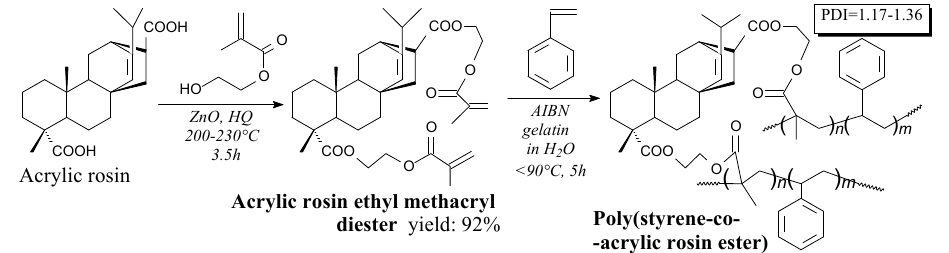
Levopimaric acidHOOC Scheme 82. Preparation of idealized rosin-tung oil Diels-Alder adduct.